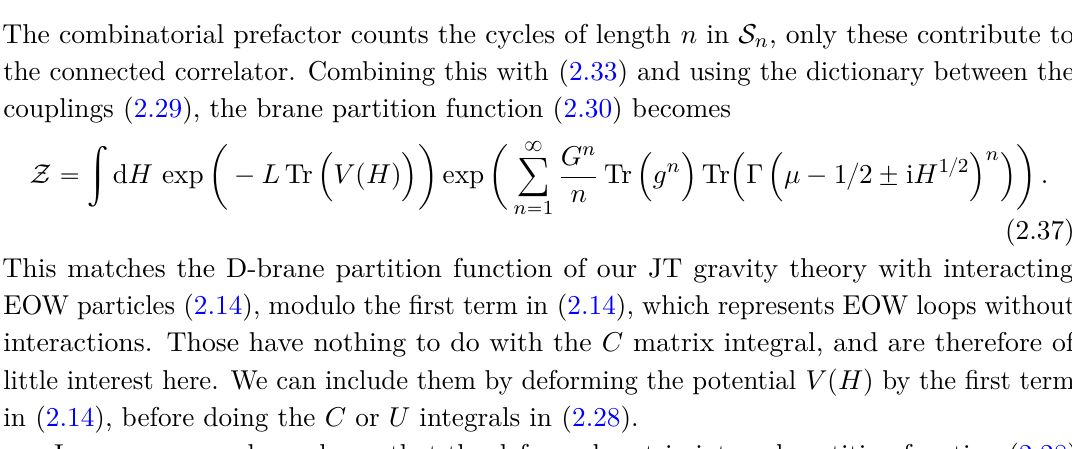
Figure 3 . Haar random unitaries. Wires contract indices, integrating over Haar random unitaries corresponds with inserting complete sets of wire states, Weingarten functions weight each bra-ket combination. Dominant terms for large L have identical bra and ket (middle), the subleading terms have different bra and ket